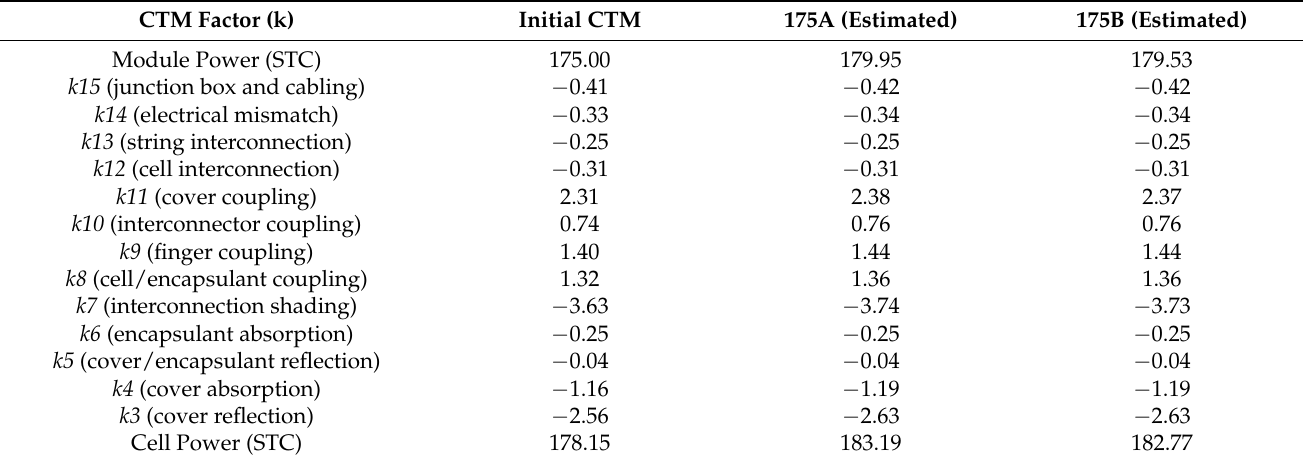
Table 4. Calculation of theoretical output values for each step of 175A/175B